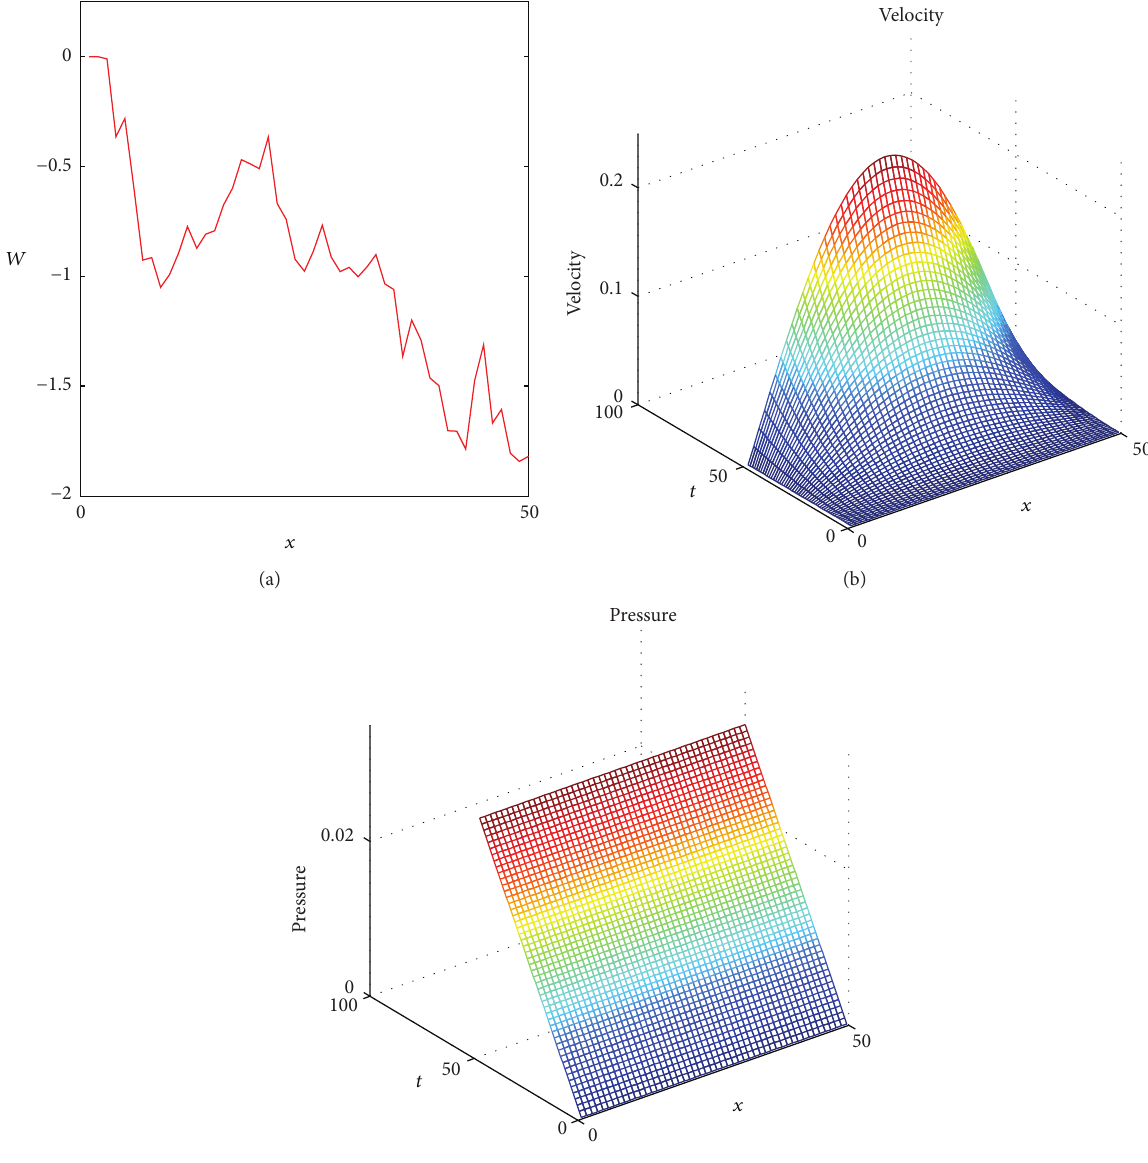
Figure 3: The Brownian, the associated velocity and pressure, and stable